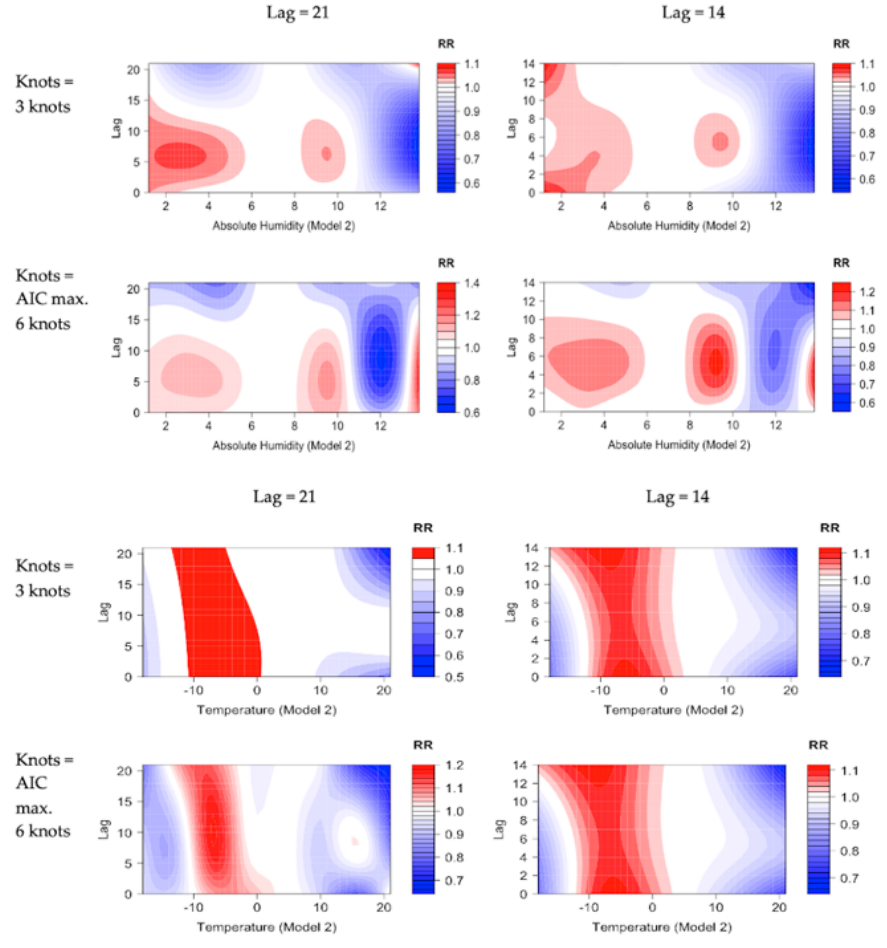
Figure 4. Relative risks of COVID-19 by absolute humidity, temperature, and lag, compared to the reference values of 7 g/m 3 and +5 °C. The figures present RR for Model 2 with lag up to 21 and 14 days in the Helsinki-Uusimaa hospital district (HUS) for the time period 1 August 2020 until 31 May 2021. The results were calculated for both a fixed number of three knots and using AIC with a maximum of six knots. Increased relative risk is presented in red, decreased risk in blue, and white indicates no significant difference .